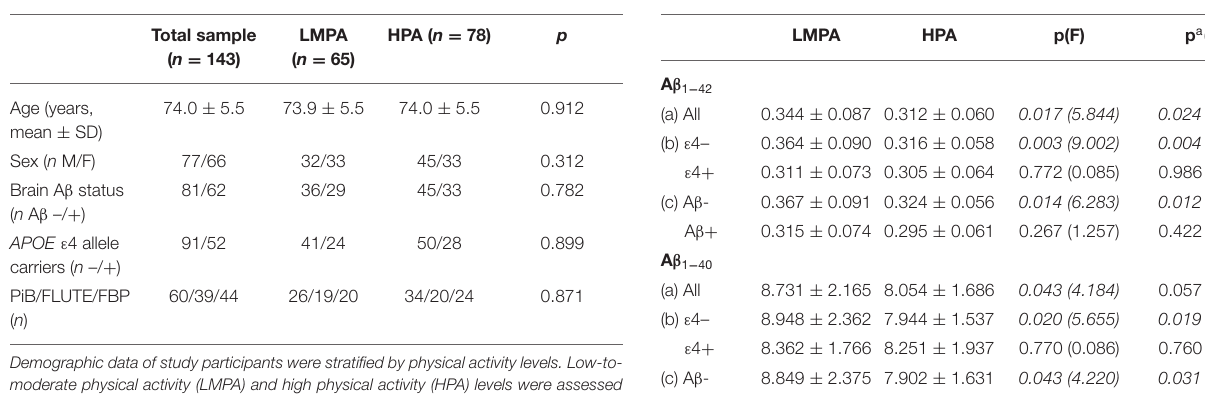
TABLE 1 | Demographic information of study participants based on self-reported physical activity groups.